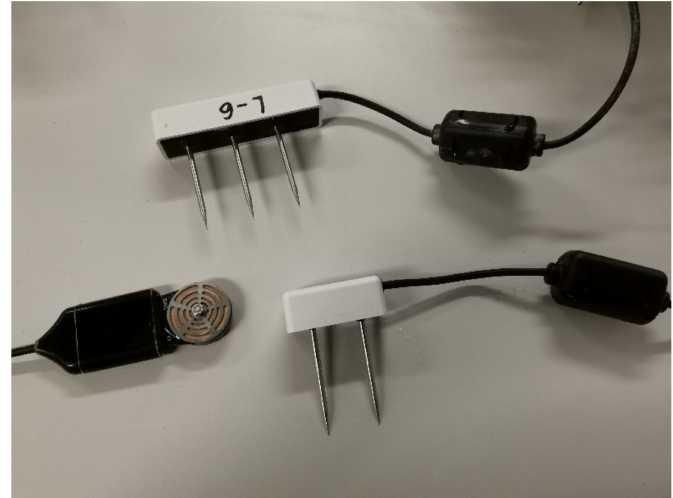
Figure 5. Soil moisture and soil water potential sensors: TEROS 10 with two needles and TEROS 12 with three needles. In the figure is also soil water potential sensor TEROS 21 with a ceramic disc.